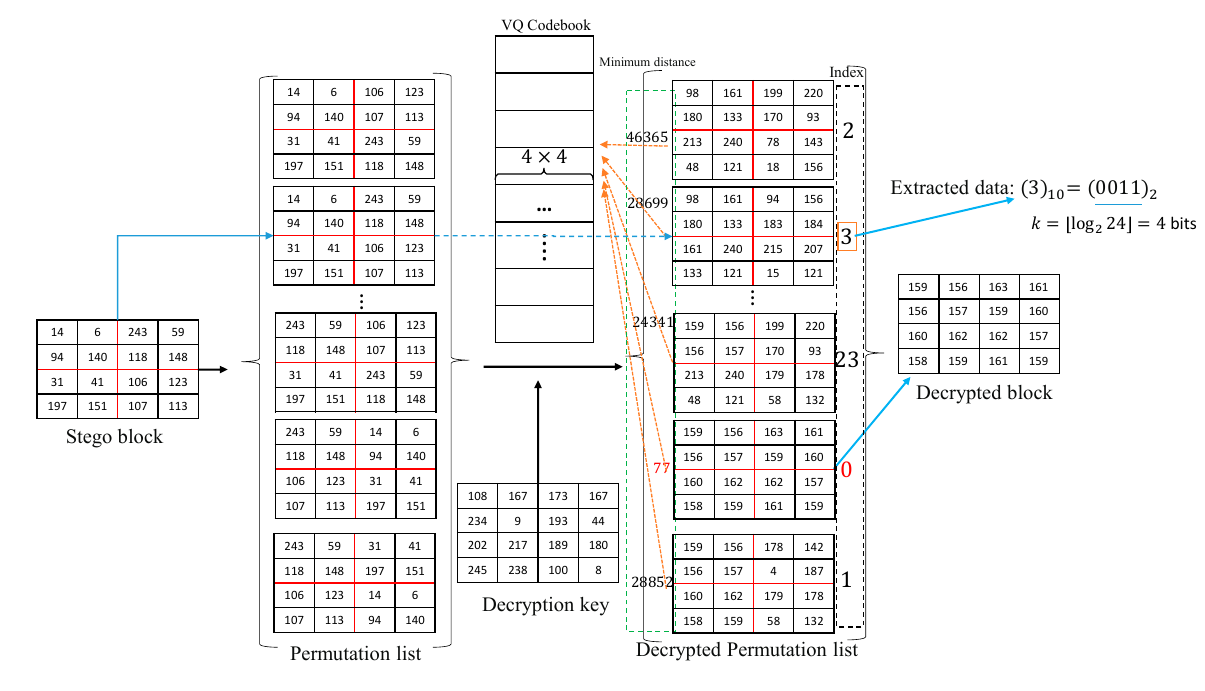
Figure 6. An example of the extraction process in which the 4 × 4-pixel block is divided into 4 sub-blocks.